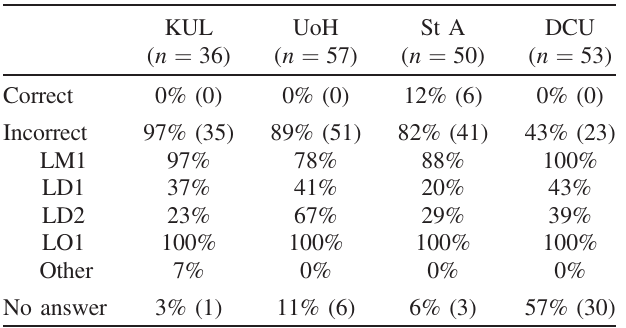
TABLE V. Summary of responses to question 2(a) [Fig. 1(b)]. Incorrect responses are associated with the errors listed in Table I. Since students can exhibit multiple difficulties in a single sketch, the percentages do not sum to 100.